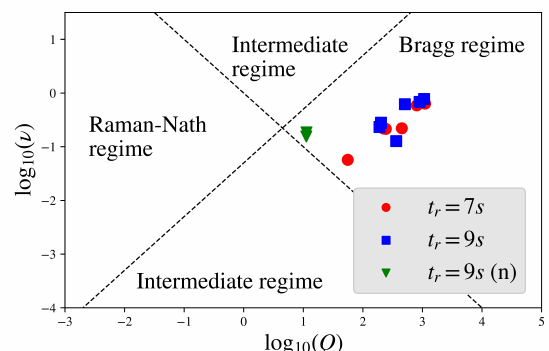
Figure 3. Classification of the samples into the diffraction regimes. Red markers resemble samples with a 7s recording time and blue markers those with 9s, both in the context of light diffraction. In contrast, green markers indicate neutron diffraction.